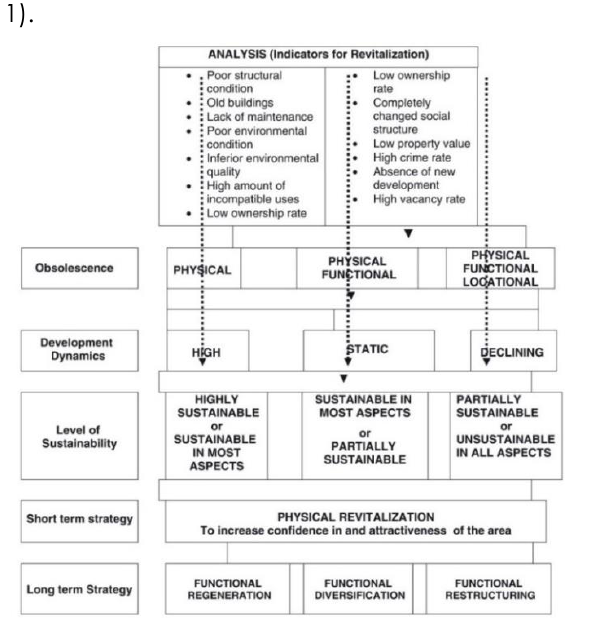
Figure 1: The most relevant strategic approach according to analysis and level of sustainability